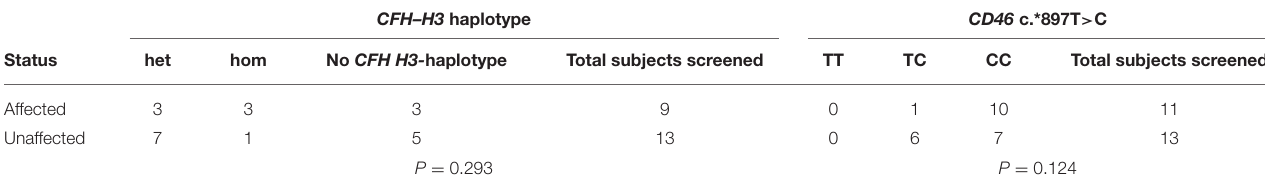
TABLE 3 | Analysis showing that CFH–H3 and CD46 GGAAC haplotypes are not associated with CD46 c.286 + 2T > G rare variant.